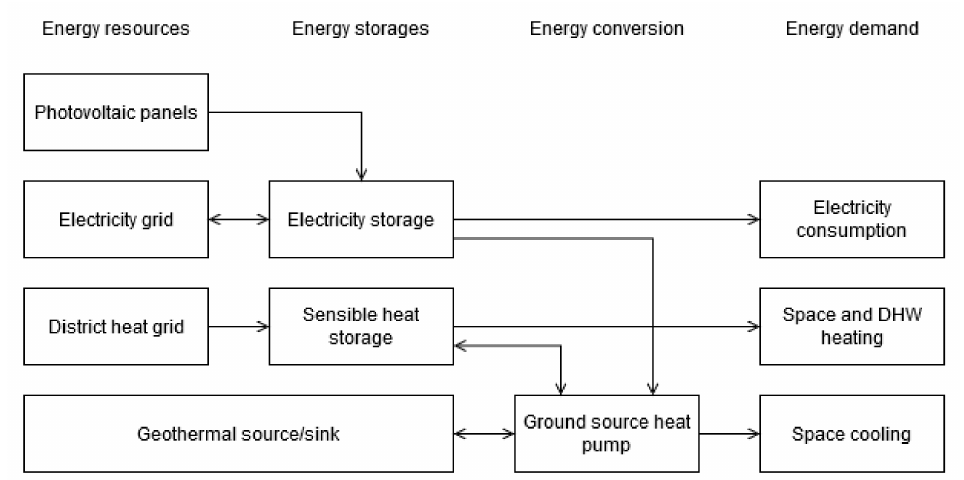
Figure 2. Diagram of the energy system optimization model for this specific case. The main com- ponent enabling flexibility is the ground source heat pump, which links separate energy carriers through its energy conversion ability. In this model, energy demands are pre-defined from the dynamic building model